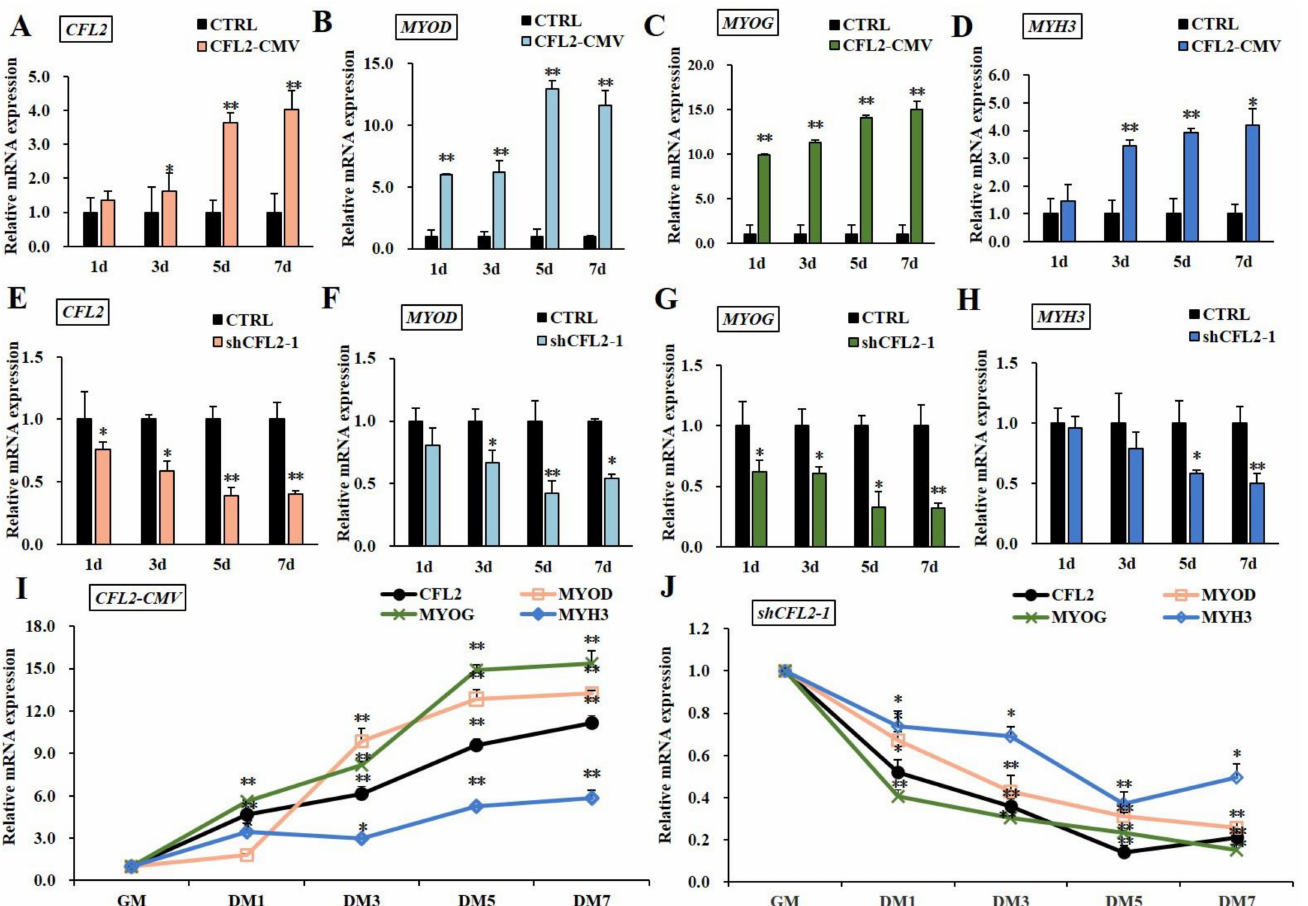
Figure 5. Effects of the CFL2 gene on the differentiation of PBMs. After being treated with CFL2- CMV ( A – D ) or shCFL2-1 ( E – H ) induced cells differentiate for 7 days by DM in PBMs; subsequently, the mRNA levels of CFL2 gene and myogenic marker factors MYOD , MYOG and MYH3 were examined once on alternate days. Then, the developmental expression patterns of CFL2 gene and three myogenic marker genes from GM to DM7 were further examined after being treated with CFL2-CMV ( I ) or shCFL2-1 ( J ) in PBMs. Mean data ± SE of n = 3 independent experiments,